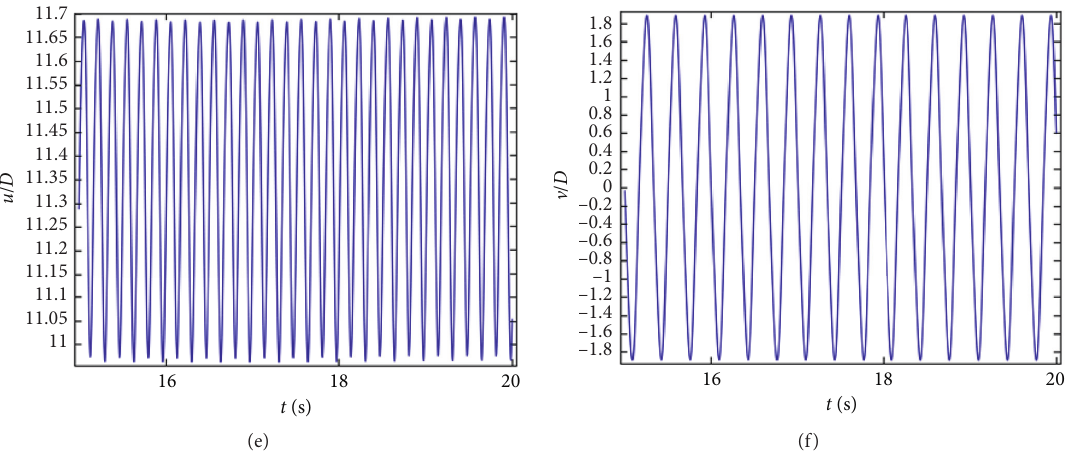
Figure 18: Displacement response at the axial center of the marine riser under the condition of different gas-phase volume fractions. (a) The in-line and (b) cross-flow with ε g � 0. (c) The in-line and (d) cross-flow with ε g � 0.7. (e) The in-line and (f) cross-flow with ε g �